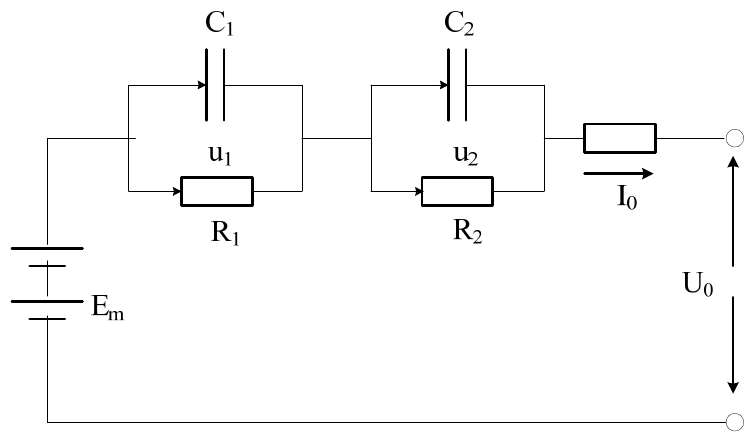
Figure 4. The equivalent circuit battery